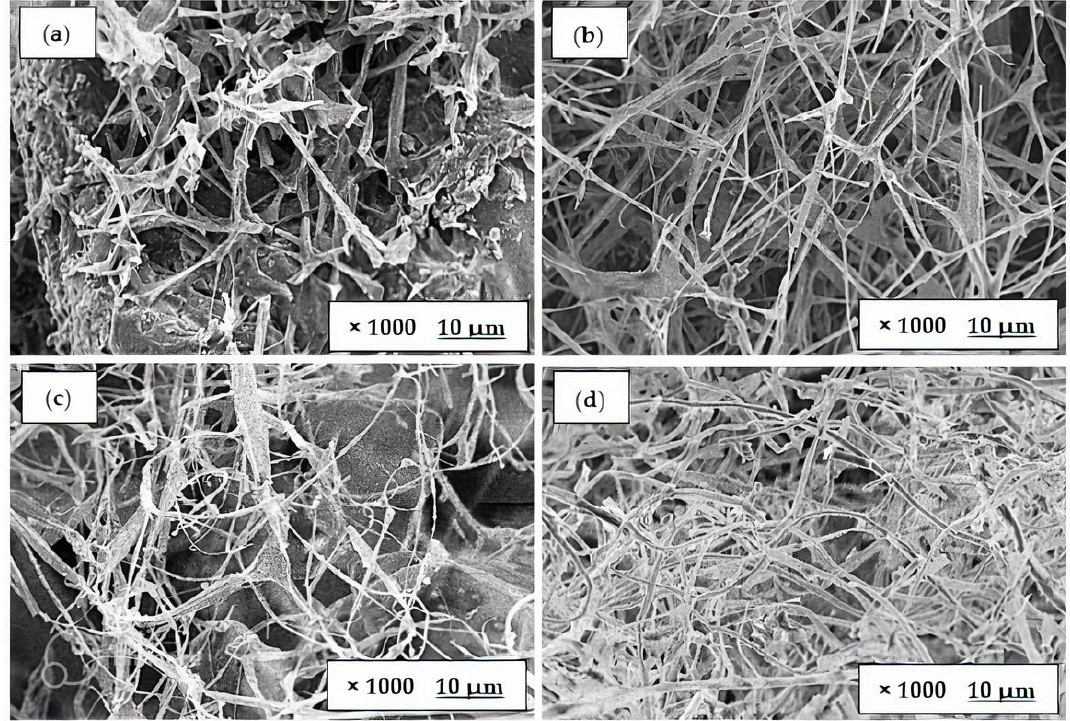
Figure 6. Morphology of fungal foam using Pleurotus citrinopileatus in ( a ) rice husk, ( b ) sawdust, ( c ) sugarcane bagasse, and ( d ) teak leaves. ( c ) sugarcane bagasse, and ( d ) teak